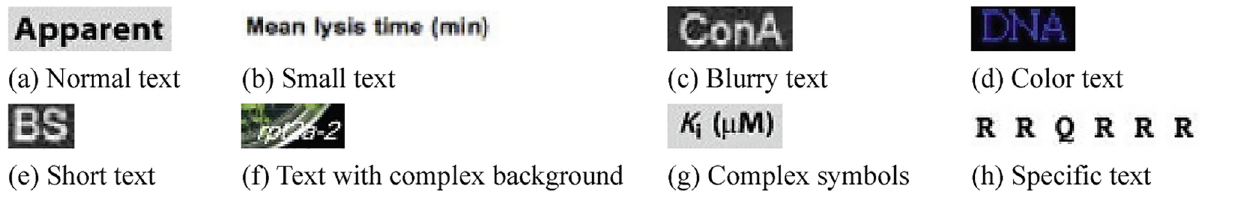
Fig 6. Region samples of different categories.